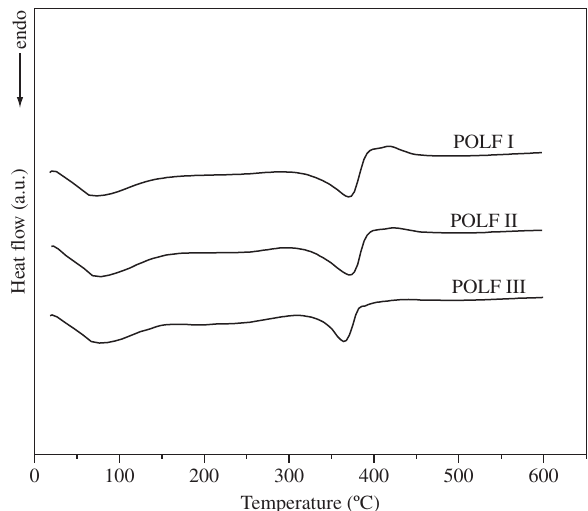
Figure 3. Differential scanning calorimetry curves from POLF series.